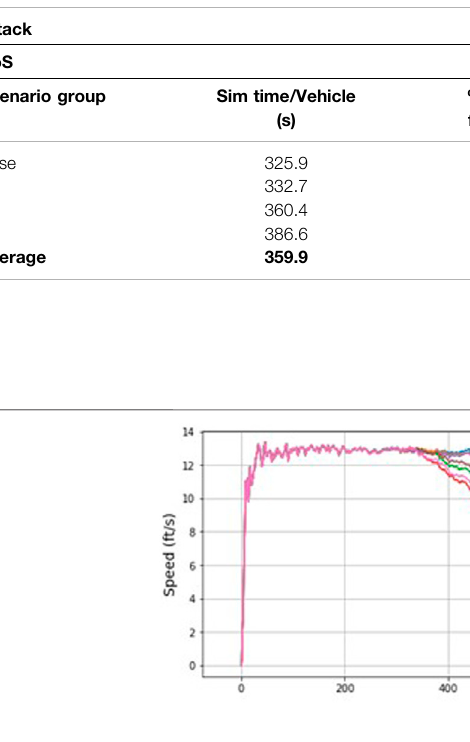
TABLE 8 | Average simulation time per vehicle comparison.